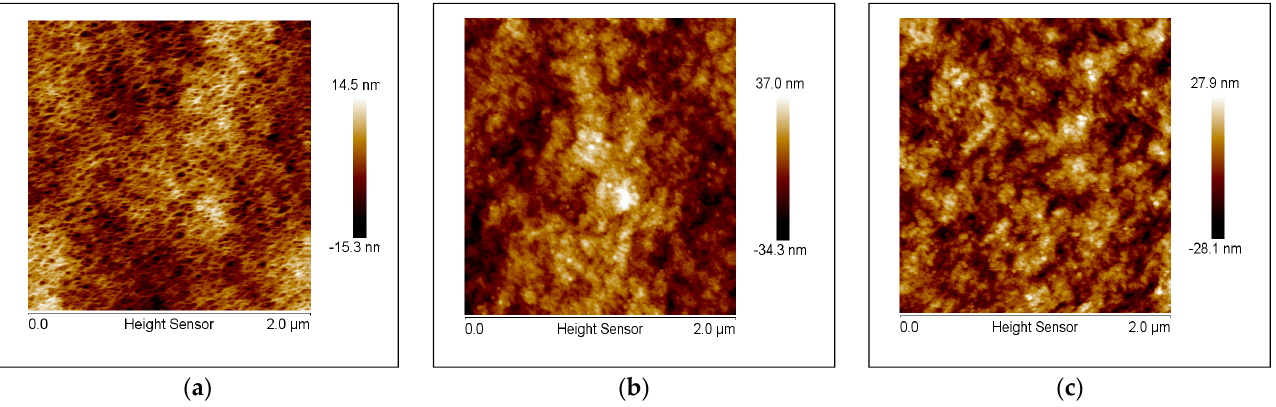
Figure 4. Atomic Force Microscopic (AFM) images of ( a ) base membrane, modified membranes after ( b ) 1-hour polymerization and ( c ) 4-hour polymerization. The initiator was immobilized on the inner pore and outer membrane surface.